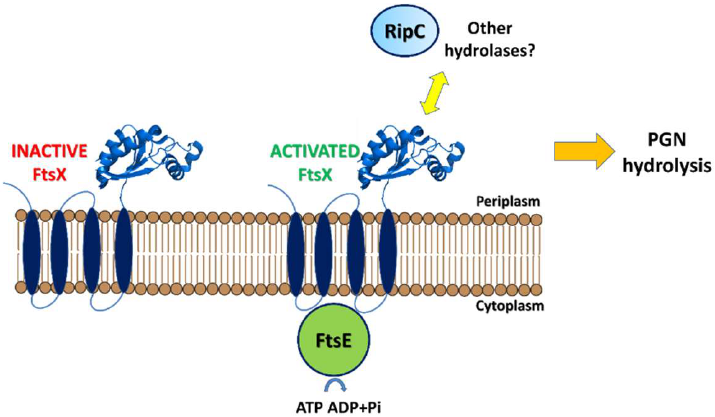
Figure 7. Model for the activation of hydrolases by FtsX. FtsE hydrolyzes ATP to ADP upon sensing an unknown signal from inside the cell. This hydrolysis causes a conformational change that is transmitted through the membrane via FtsX. A conformational change of the extracellular part of FtsX results in interaction with either cell wall hydrolases or effector proteins and activation of PGN hydrolysis.